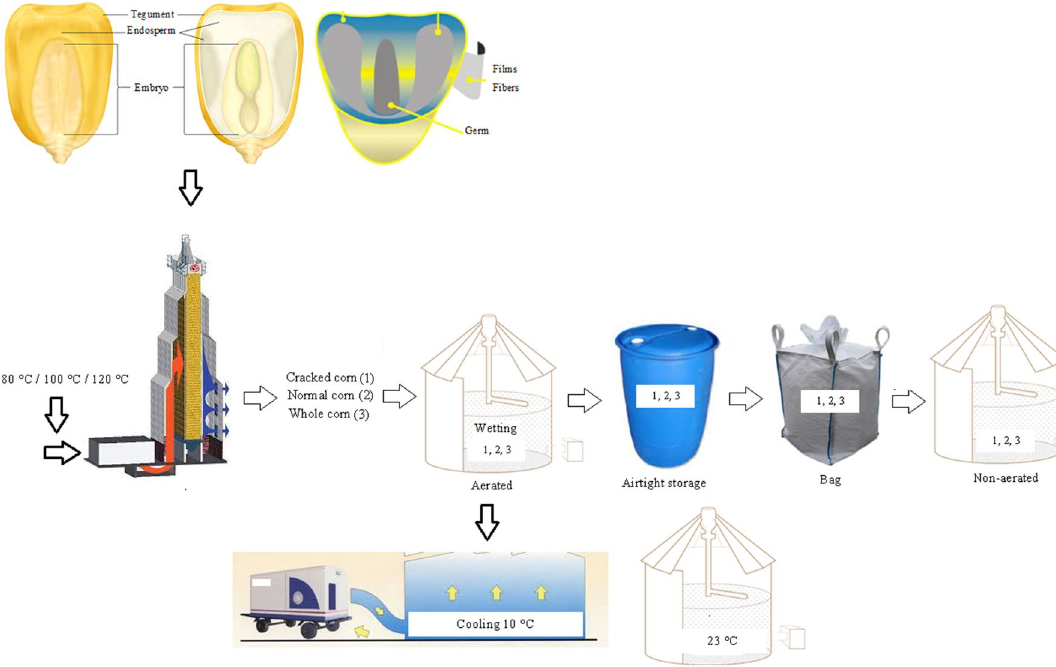
Figure 6. Material flow for the field